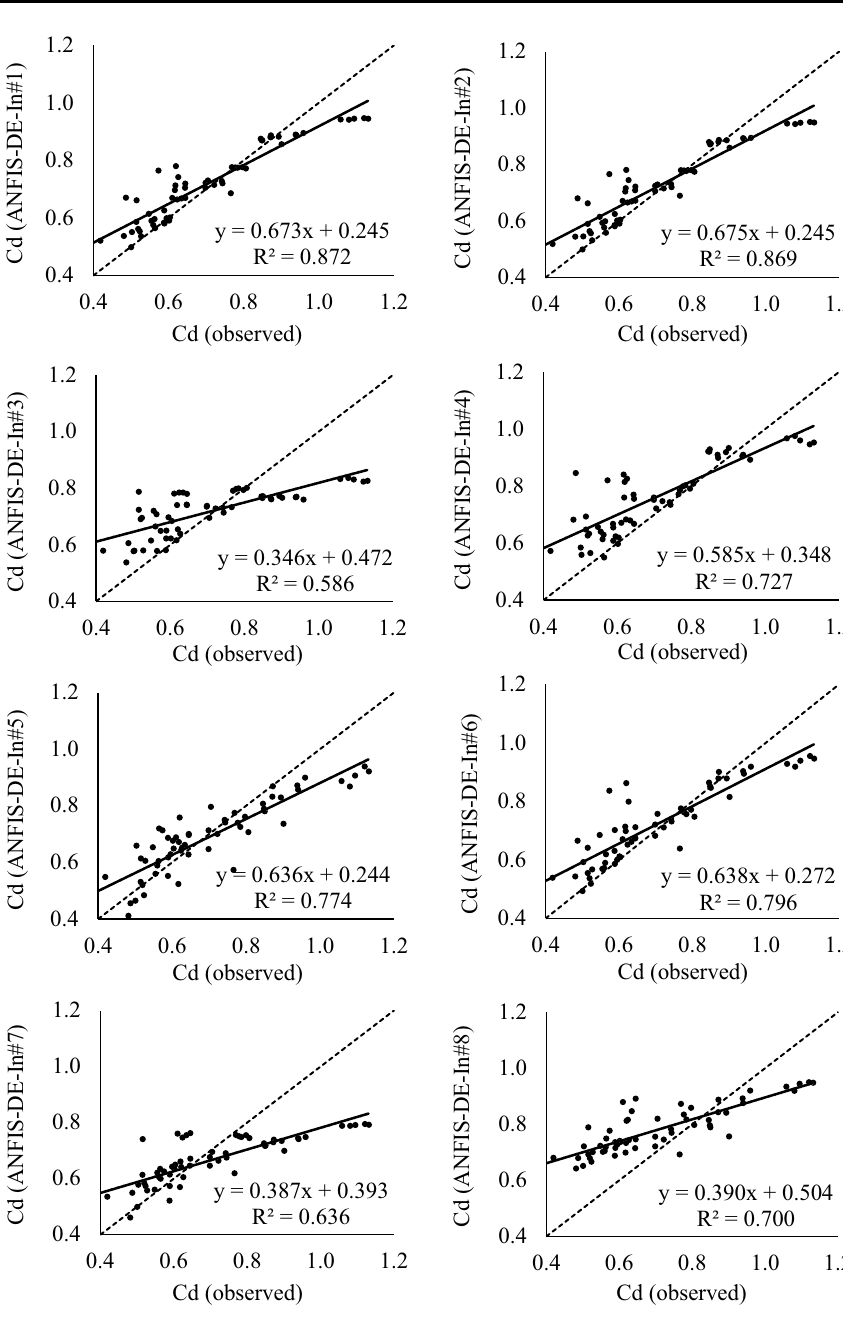
trendline and trendline equation are shown. The trendline equation is defined as: , y = C x + C 1 2 and C are the equation constants. A value of C where C 1 2 closer to 1 and a value of C closer to 0 represent a more 2 accurate model. This figure indicates that for all input combinations, ANFIS-DE is trapped in overestimation for Cd < 0.8 and trapped in underestimation for Cd > 0.8. In